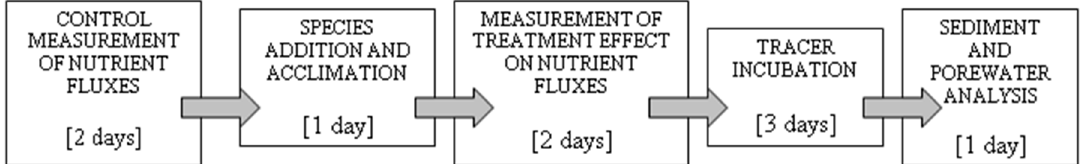
Figure 1. Sequence of experimental procedures carried out during experimental runs with natural sediment in experiment 2 (see text for explanations).